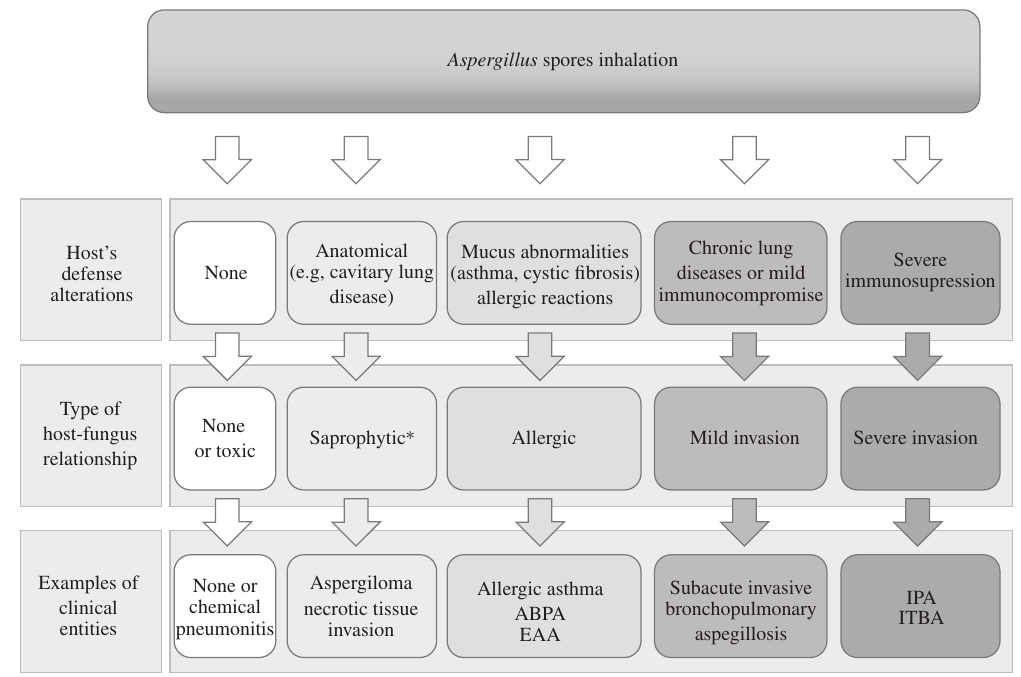
FIGURE 1: Classification of the Aspergillus- related respiratory diseases based on their pathogenesis, including the status of antifungal defense and the type of host-fungus relationship (upper and middle row, respectively) (based on [13], modified). ∗ In many patients, a true saprophytic nature of the infection is difficult to prove and might be questionable. Note, that in fact, not only vertical (showed with arrows), but also horizontal relationships might exist in the middle and bottom rows (e.g., saprophytic forms can evolve into invasive forms; relationships not shown); EEA: extrinsic allergic alveolitis, ABPA: allergic bronchopulmonary aspergillosis, IPA: invasive pulmonary aspergillosis, ITBA: invasive tracheobronchial aspergillosis.